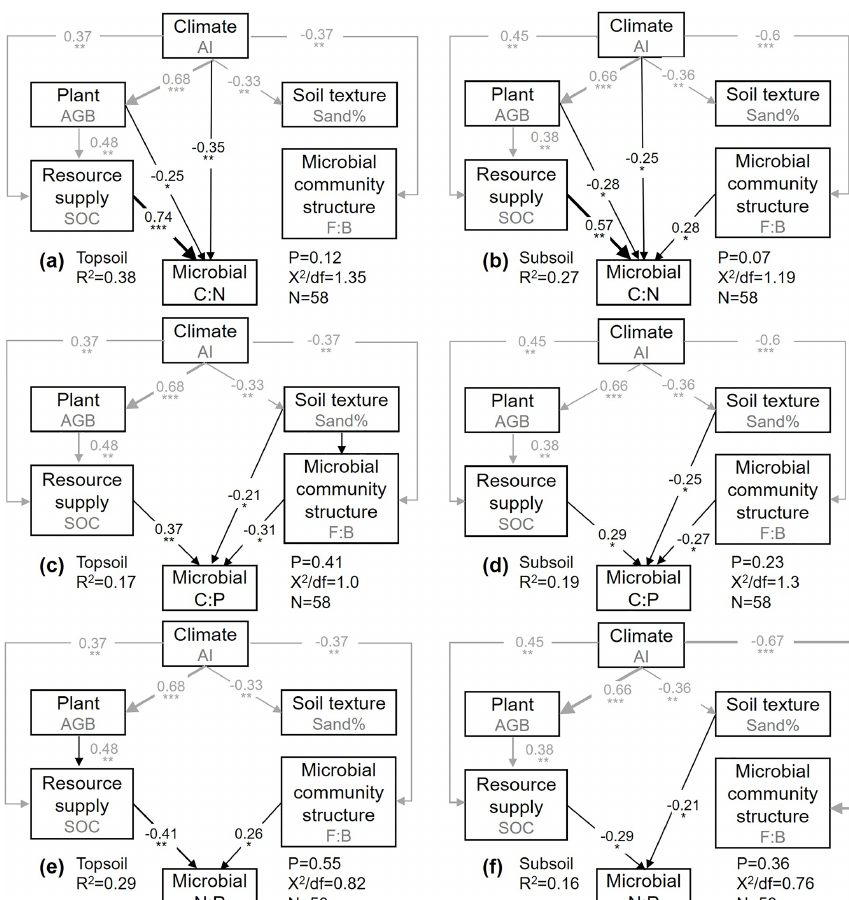
Figure 4. The structural equation model (SEM) shows the direct and indirect influences of various ecological factors on the microbial C:N (a, b) , C:P (c, d) , and N:P (e–f) ratios in the topsoil and subsoil. Black and gray arrows indicate direct and indirect pathways, respectively. Numbers on the arrows indicate standardized path coefficients, proportional to the arrow width. R 2 indicates the variation in the microbial C:N and C:P ratios explained by the model. ∗ P < 0 . 05; ∗∗ P < 0 . 01; ∗∗∗ P < 0 .